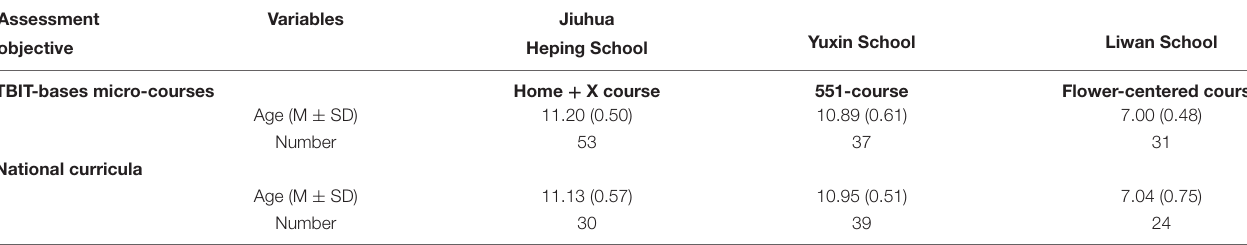
TABLE 2 | Descriptive statistics of subjects in two assessments and three